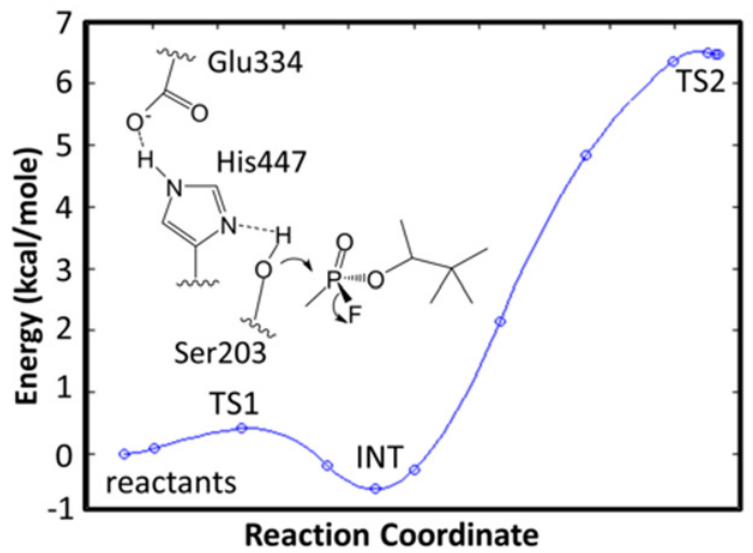
Fig 5. The energy barriers for the adduction of soman to the active site Ser203 by QM calculations. Each step is a single DFT geometry optimization calculation. The structure (S1 Fig) from the final geometry optimization was used as the starting point for the classical MD simulations of the soman-adducted human AChE. The 6.5 kcal/mole barrier value is similar to the experimentally determined value of 9.1 kcal/mole for that of sarin.